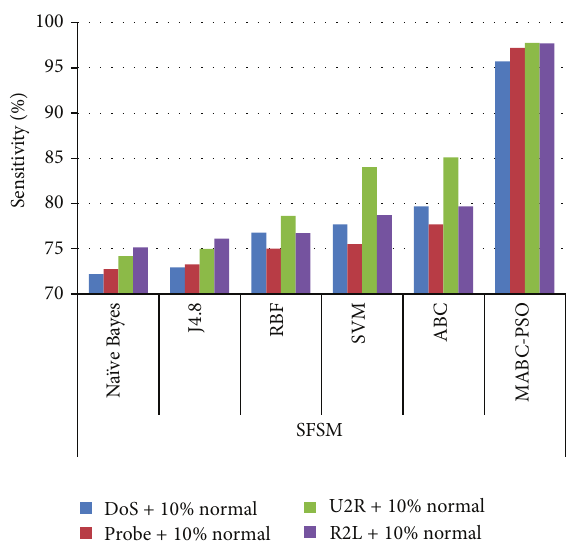
Figure 7: Comparison on sensitivity using SFSM method.